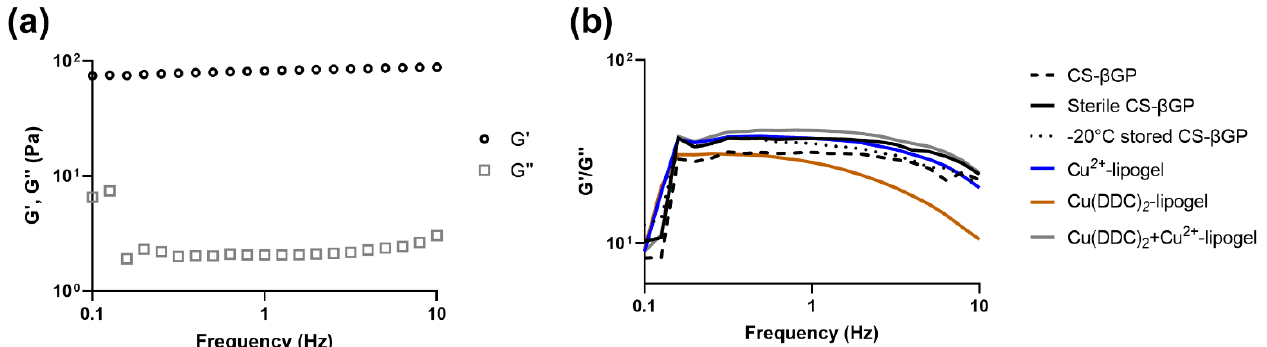
Figure 5. Frequency sweep (0.1 –10 Hz) of chitosan with β -glycerophosphate (CS- β GP) gels and lipogels at 37 °C. ( a ) Representative curve of storage modulus (G ′ ) and loss modulus (G ″ ) of sterile CS- β GP gel and ( b ) ratio of G ′ /G ″ of CS- β GP gels exposed to sterilization procedures, stored at − 20 °C or with incorporated liposomes. Data are expressed as mean (n = 3).